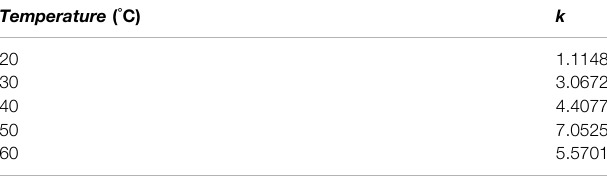
TABLE 1 | k values fi tted at different